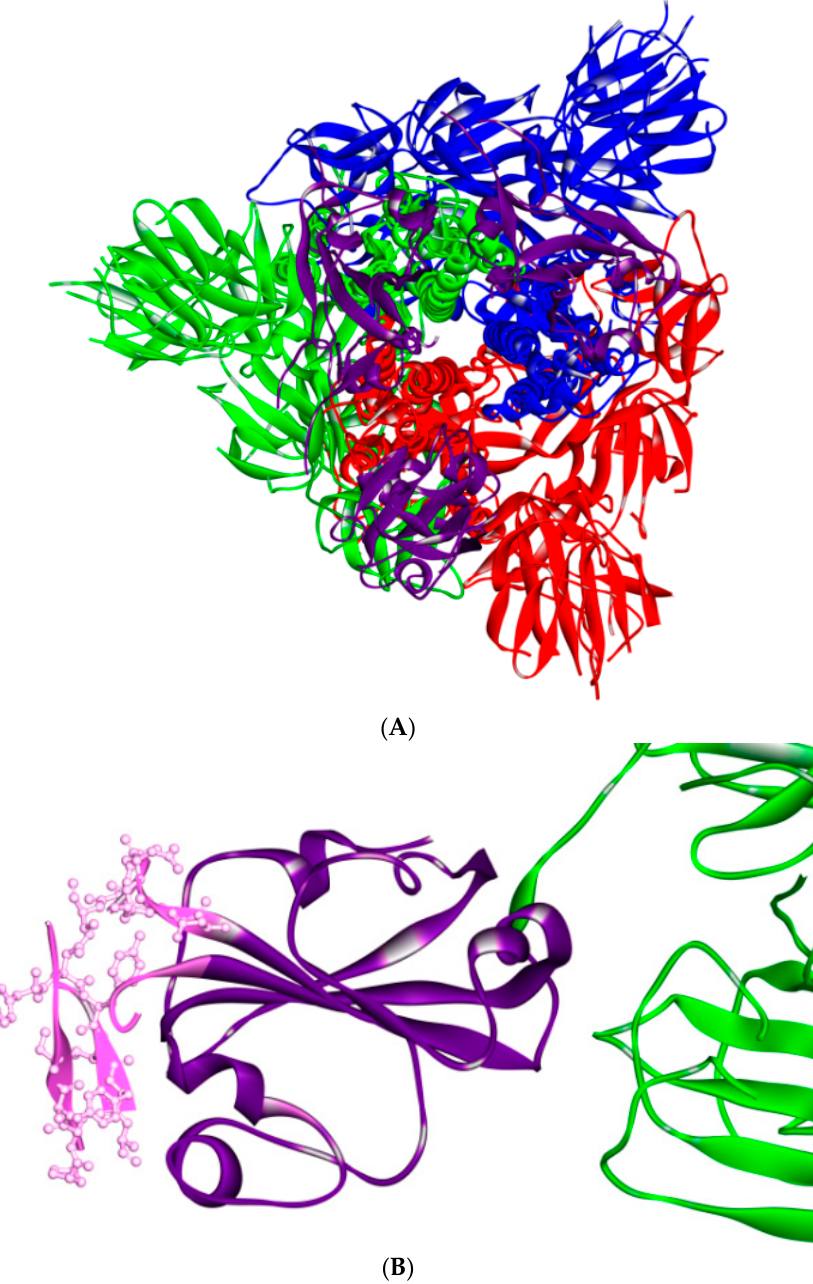
Figure 7. Structure of S protein (PDB ID: 6vsb) [14]. ( A ) RBD is shown in violet. ( B ) Close side view of RBD in violet, with receptor-binding motif (RBM) annotated in pink. Three-dimensional models were created using Discovery Studio (version 2.5.5, Biovia, San Diego, CA, USA).